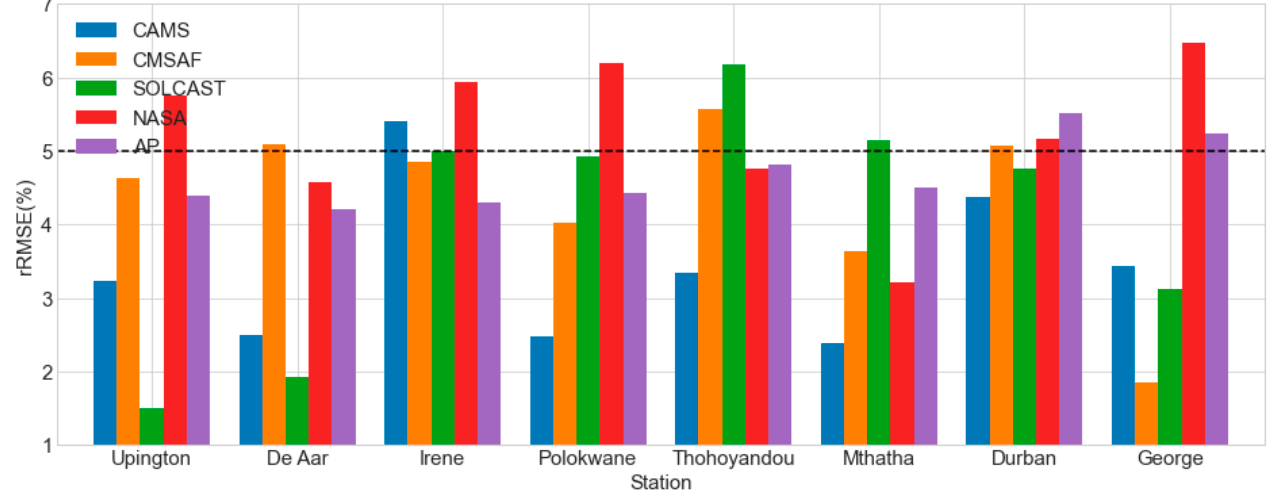
Figure 7. The daily rRMSE of the calculated GHI datasets under clear skies.